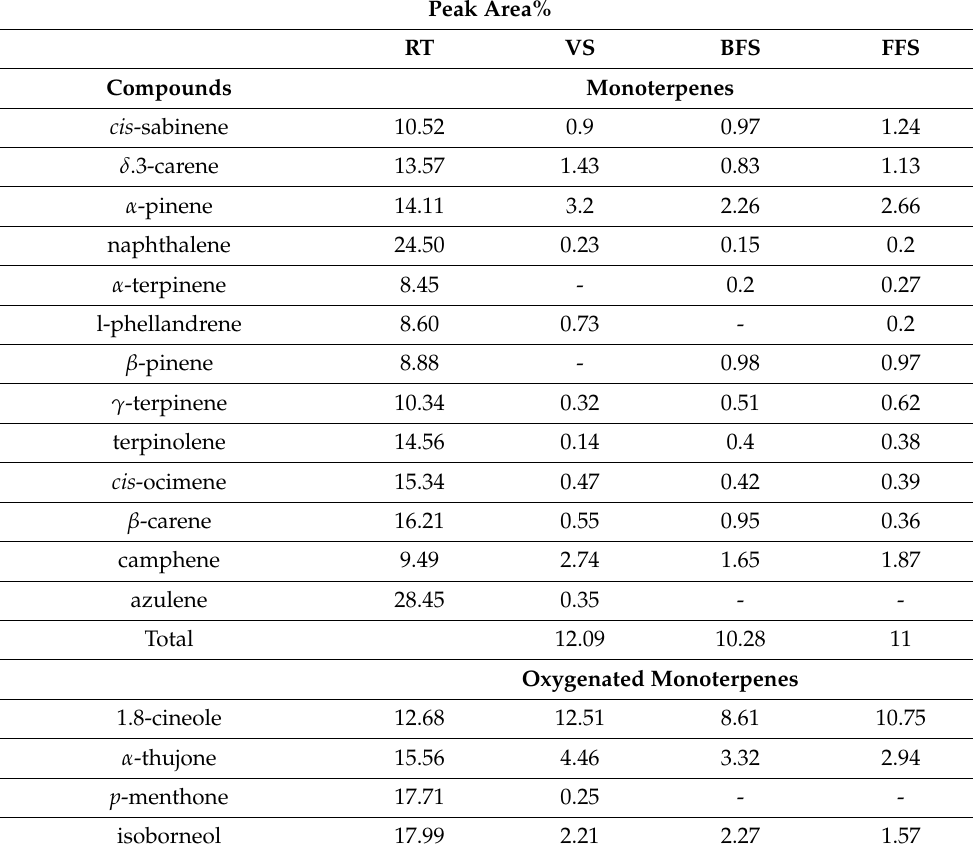
Figure 3. GC chromatography of SOEO at full flowering stage. Regarding oxygenated monoterpenes, naphthalenone was the major compound with percentages of 22.9, 22.39, and 20.81% for the vegetative stage (VS), beginning of flowering stage (BFS), and full flowering stage (FFS), respectively. The second main compound was camphor, which showed the highest percentage during the vegetative stage (16.29%), followed by 1.8-cineole (12.51%), and α-thujone (4.46%). However, for sesquiterpene hydrocarbons, the full flowering stage showed the highest concentrations of major compounds; trans-caryophyllene (9.61%), eremophilene (8.37%), and α-humulene (8.34%) (Table 1). Table 1. Chemical composition of S. officinalis at three phenological stages .